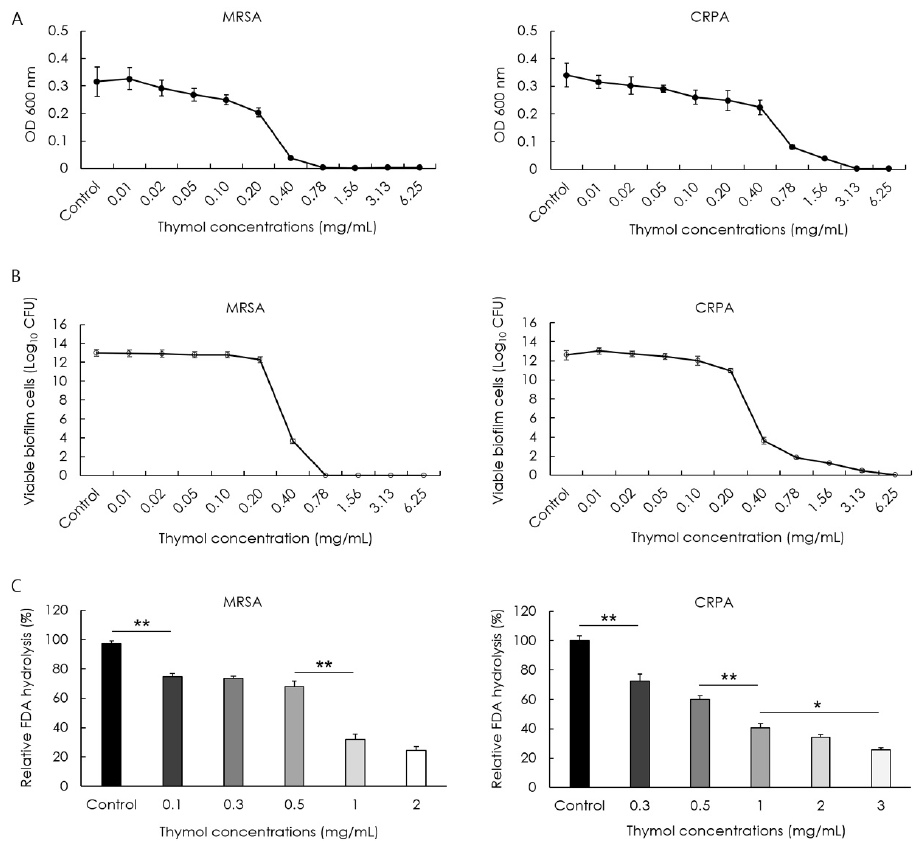
Figure 4. The activity of thymol against the preformed biofilms of methicillin-resistant Staphylococcus aureus (MRSA) and ciprofloxacin-resistant Pseudomonas aeruginosa (CRPA). Eradication and hydrolytic activity were determined following treatment with thymol for 24 h. The rates of MRSA and CRPA biofilm eradication increased in response to exposure to increasing concentrations of thymol. The minimum biofilm eradication concentrations (MBECs) of thymol by optical density measurements against preformed MRSA and CRPA biofilms were 0.78 and 3.13 mg/mL, respectively ( A ). The MBEC of thymol by viable cell counts against preformed MRSA and CRPA biofilms were 0.78 and 6.25 mg/mL, respectively ( B ). The hydrolytic activity of biofilms produced by MRSA and CRPA decreased significantly in response to exposure to increasing concentrations of thymol ( C ). Data are shown as the means ± standard errors of the mean of five independent experiments (CFU; colony-forming units, FDA; fluorescein diacetate, ** p < 0.01; * p <